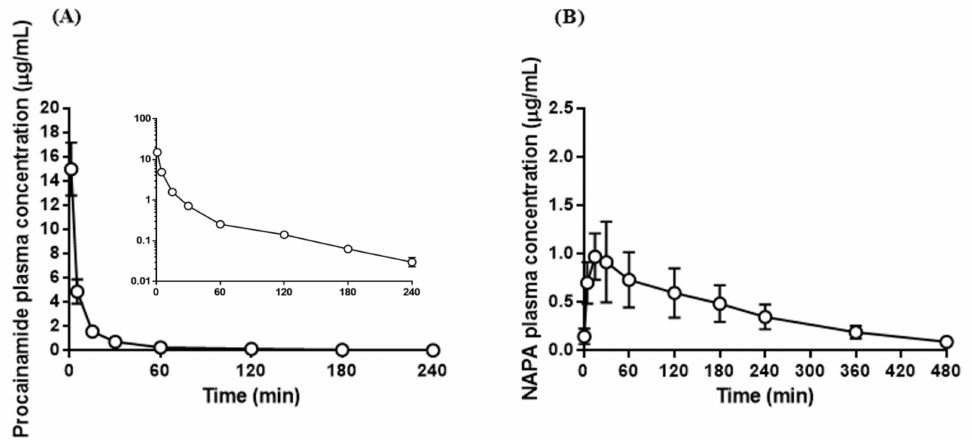
Figure 3. Application of the developed method to a pharmacokinetic study of procainamide; Plasma concentration-time profile of ( A ) procainamide and ( B ) N -acetylprocainamide after intravenous administration of procainamide hydrochloride (10 mg/kg) in rats (mean ± SD, n = 5). Table 3. Pharmacokinetic parameters of procainamide and its metabolite, N -acetylprocainamide after intravenous administration of procainamide hydrochloride (10 mg/kg) in rats (mean ± SD, n = 5).